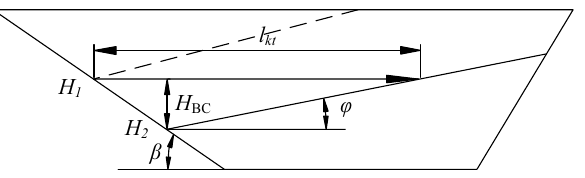
Table 4 Horizontal advancing speed of mining working line